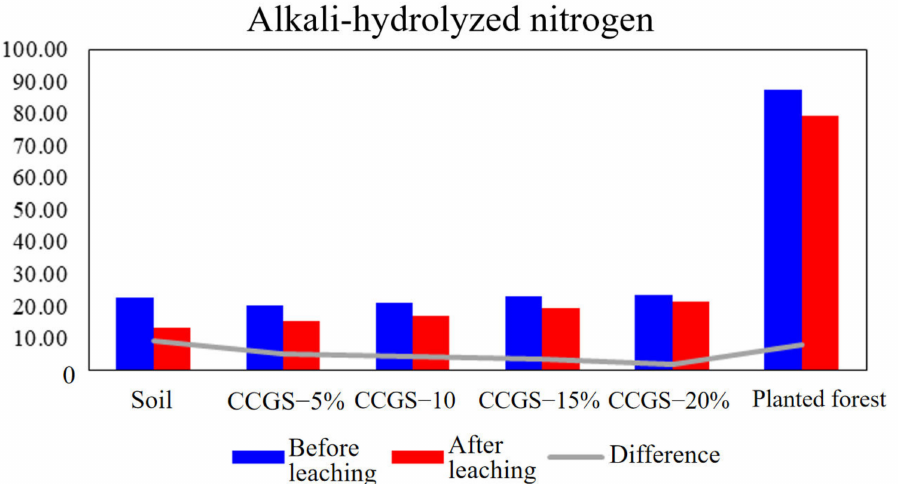
Figure 15. Effect of CCGS on alkali-hydrolyzed